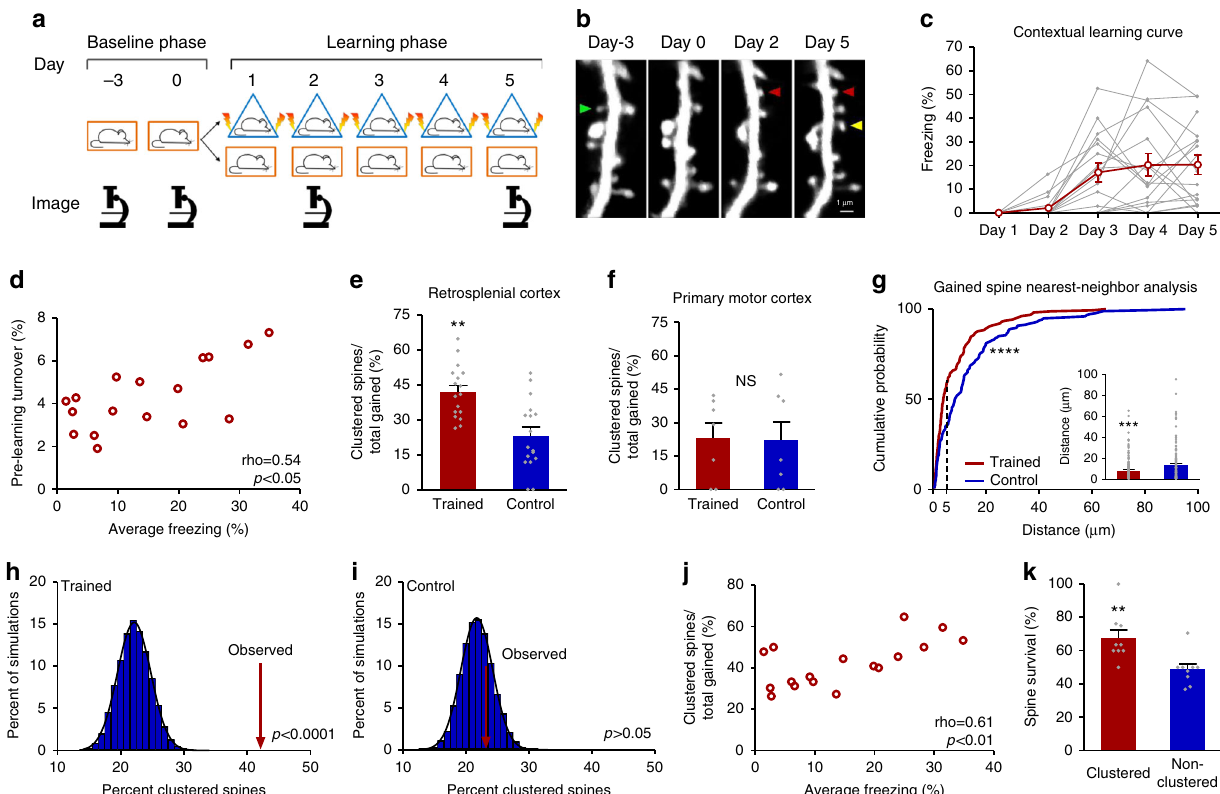
Fig. 1 Pre-training dendritic spine turnover and learning-related spine clustering correlate with contextual learning. a Timeline of contextual learning and imaging. b Representative example of longitudinal imaging. Lost spine is denoted by green arrowhead. One gained spine is denoted by a red arrowhead; another gained spine (yellow arrowhead) is added by day 5 within 5 µ m, thus forming a cluster. Scale bar indicates 1 µ m. c Learning curve of mice during CFC. d Dendritic spine turnover before training correlates with future learning. Scatter plot shows spine turnover before training vs. average contextual freezing ( n = 17 mice; Spearman ’ s rho = 0.54, p = 0.0255). e Trained mice have a higher percentage of newly added spines that occur in clusters ( ≤ 5 μ m) (Trained = 42.0% vs Control = 23.2%, n = 17 mice per group; Mann – Whitney U = 51.00, p = 0.0014). f Contextual learning does not increase spine clustering in primary motor cortex (Trained = 23.0% vs Control = 22.0%, n = 7 mice per group; U = 24.00, p = 1.00). g CFC signi fi cantly shifts inter-spine distances between gained spines toward smaller values. (Trained, n = 155 distance measurements; Control, n = 173 distance measurements; Two-sample Kolmogorov – Smirnov, D = 0.2610, p = 2.1006e − 05). Inset is mean ± s.e.m. of values in distribution (8.3% vs 13.6%, Mann – Whitney U = 10294, p = 0.0003). h Clustered spine addition is signi fi cantly greater than chance. The histogram shows percent clustering from 10,000 simulations of randomized new spine positions; arrow represents spine clustering observed from data; black line is Gaussian fi t (mean of Gaussian fi t = 22.1%, observed = 42.0%, n = 17 mice; p < 0.0001). i In control mice, spine clustering is not greater than chance. Histogram is calculated as in h but using control mice data; arrow represents percentage of clustered spines observed from data; black line is Gaussian fi t (mean of Gaussian fi t = 21.7%, observed = 23.2%, n = 17 mice; p > 0.05). j Clustered spine formation is linearly correlated with freezing averaged from Day 2 to Day 5 ( n = 17 mice; Spearman ’ s rho = 0.61, p = 0.0088). k Clustered spines have a higher survival rate than non-clustered spines 4 – 6 weeks after training (67.6% vs 49.0%, n = 9 mice; Mann – Whitney U = 8.000, p = 0.0042). Data are represented as mean ± s.e.m. for c , e , f , inset of g and k . **** p < 0.0001, *** p < 0.001, ** p < 0.01; NS not signi fi